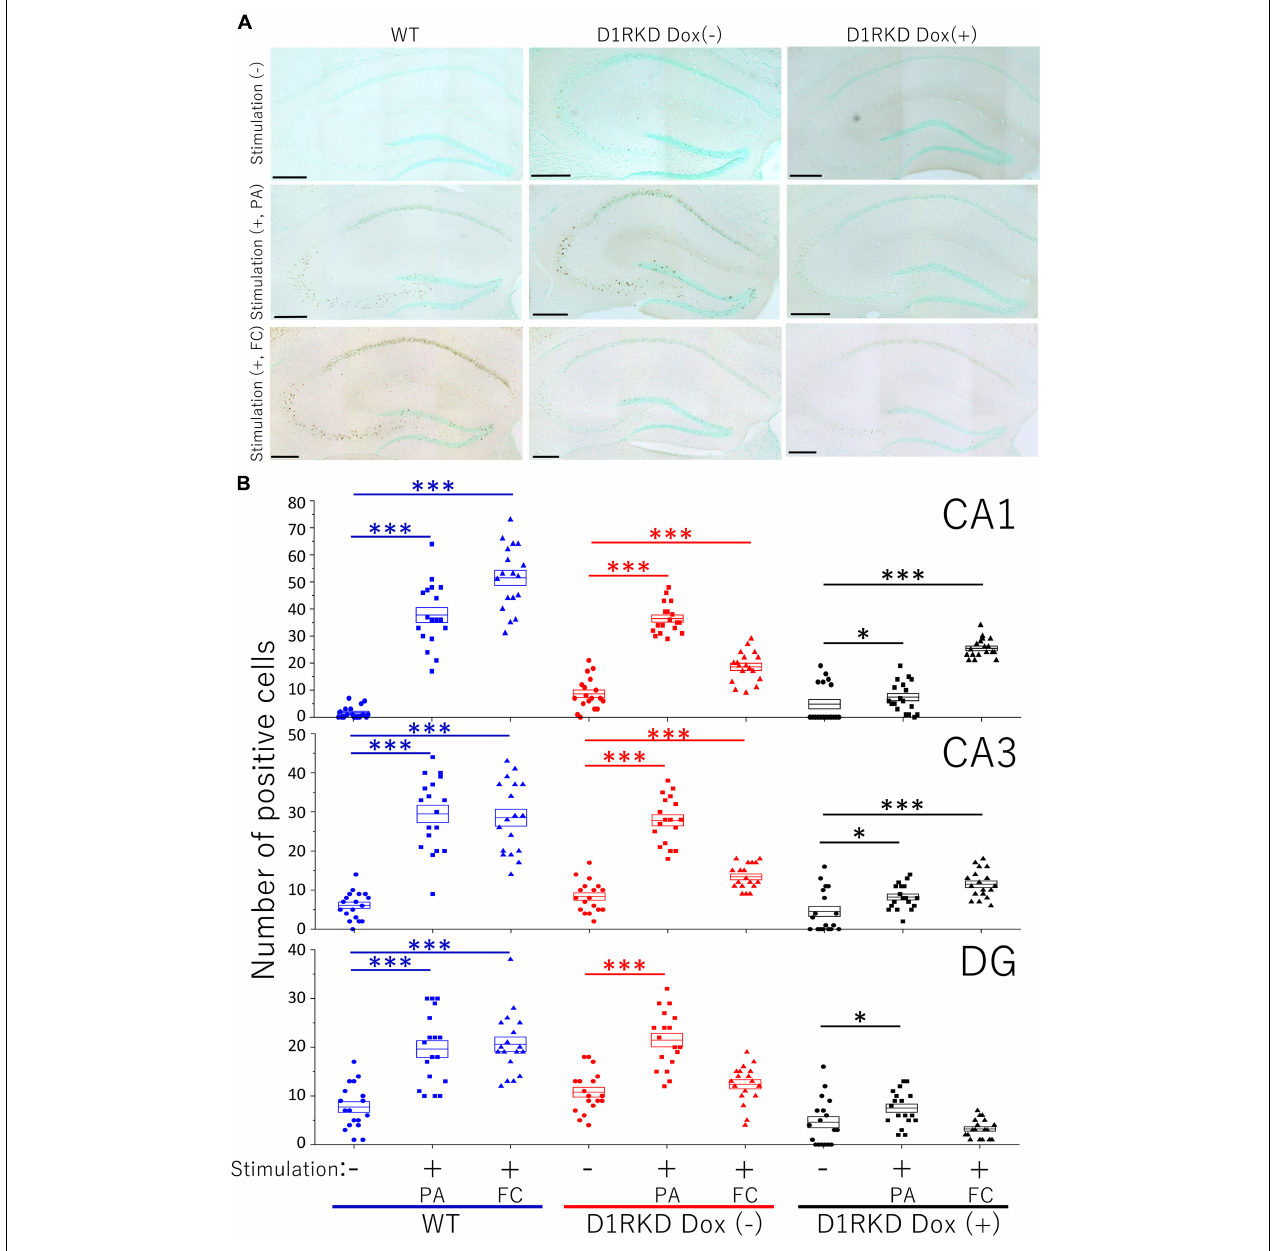
FIGURE 4 | Immunohistochemical analysis of c-Fos expression in the hippocampus (CA1, CA3, and DG) after 1 h of electric footshock stimulus using a step-through-type apparatus for the passive avoidance test (PA) or fear conditioning system (FC). (A) Representative immunohistochemical staining of c-Fos positive cells. Scale bar, 300 µ m. (B) The number of positive cells in CA1, CA3, DG in immunohistochemistry. All groups, n = 18. The blue color indicates the values of WT groups, the red color indicates the values of D1RKD Dox (–) groups, and the black color indicates the values of D1RKD Dox (+) groups. The circle, square, and triangle indicate no stimulation, stimulation by PA, and stimulation by FC, respectively, ∗ p < 0.05; ∗∗∗ p <